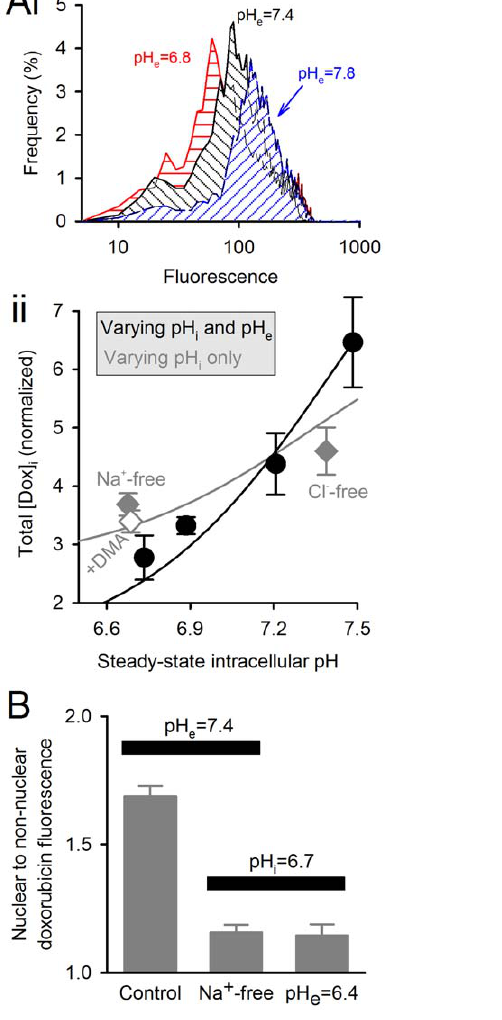
Figure 4. Importance of intracellular pH in determining doxorobucin accumulation. (A) (i) Specimen histogram of intracel- lular doxorubicin fluorescence (from . 5000 cells) at different extracel- lular pH. (ii) Plot of intracellular doxorubicin ( 6 coefficient of variation) versus intracellular pH. Black circles: intracellular pH manipulated by varying extracellular pH. Grey symbols: intracellular pH manipulated at constant extracellular pH. (B) Data from HCT116 monolayers treated with doxorobicin and Hoechst 33342. Ratio of doxorubicin fluorescence in nuclear (Hoechst 33342 positive) and non-nuclear regions quantifies the degree of drug accumulation in the nucleus.